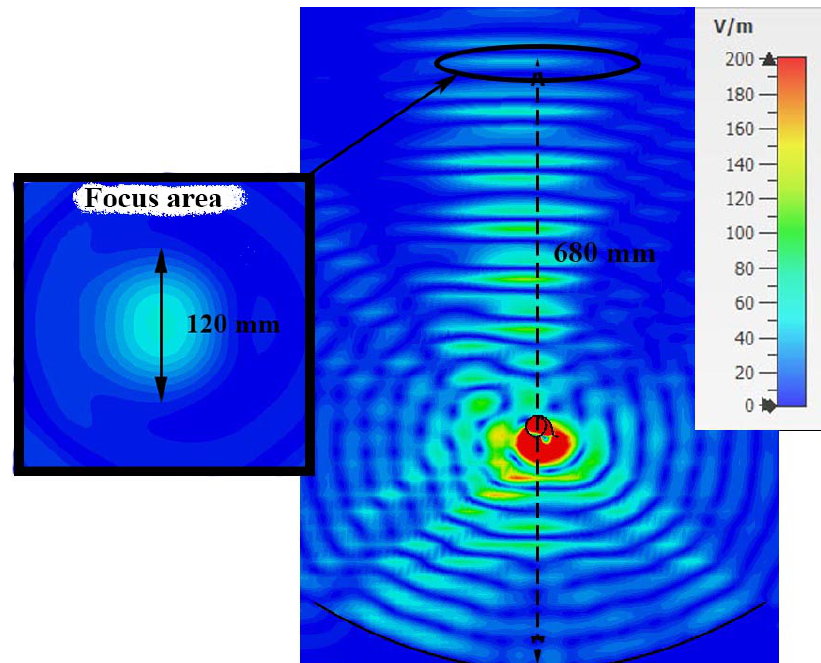
Figure 4. Field distribution in the longitudinal plane and the transverse plane at a distance of 680 mm from the reflector.